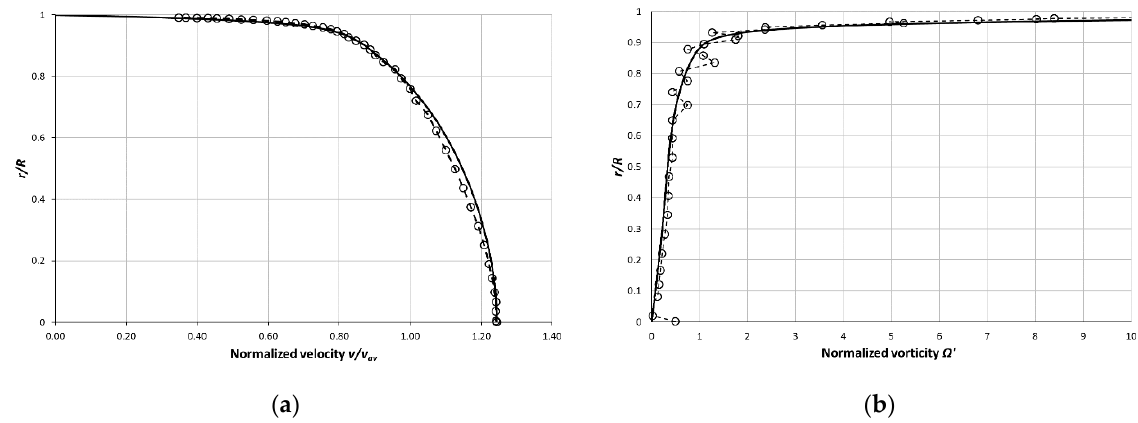
Figure 22. The experimental data (PSP) for Re = 31,577 comparison with predicted mean velocity profile. The average velocity and Re are known in this case. All other parameters are evaluated from the empirical expressions. Dashed line with circles represents the experimental data, the solid line is the analytical profile. ( a ) Normalized mean velocity profile, ( b ) Normalized vorticity distribution.